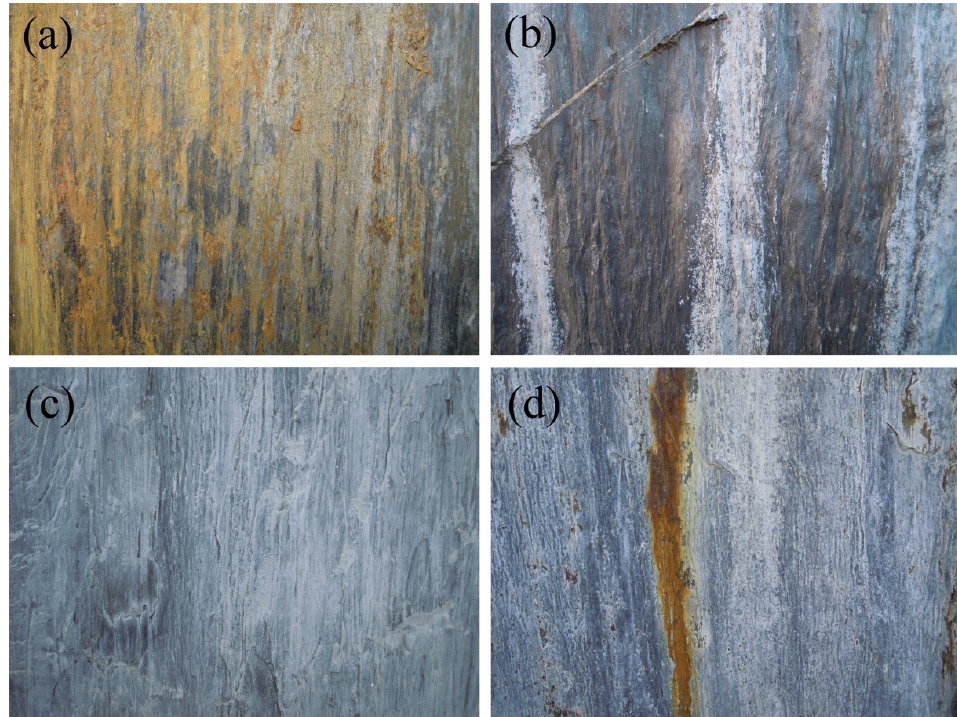
Figure 8. Color change of slate slabs: ( a ) oxidation; ( b ) deposition corresponding to water runoff; ( c ) dirty deposition of cement grouts; ( d ) oxidation. Photo credits by Fabio Sitzia.